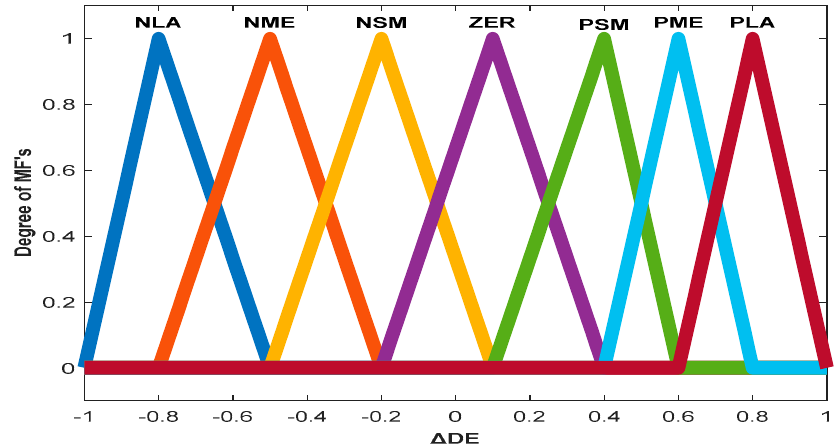
Figure 8. Input variable MFs of change in error ( Δ DE).